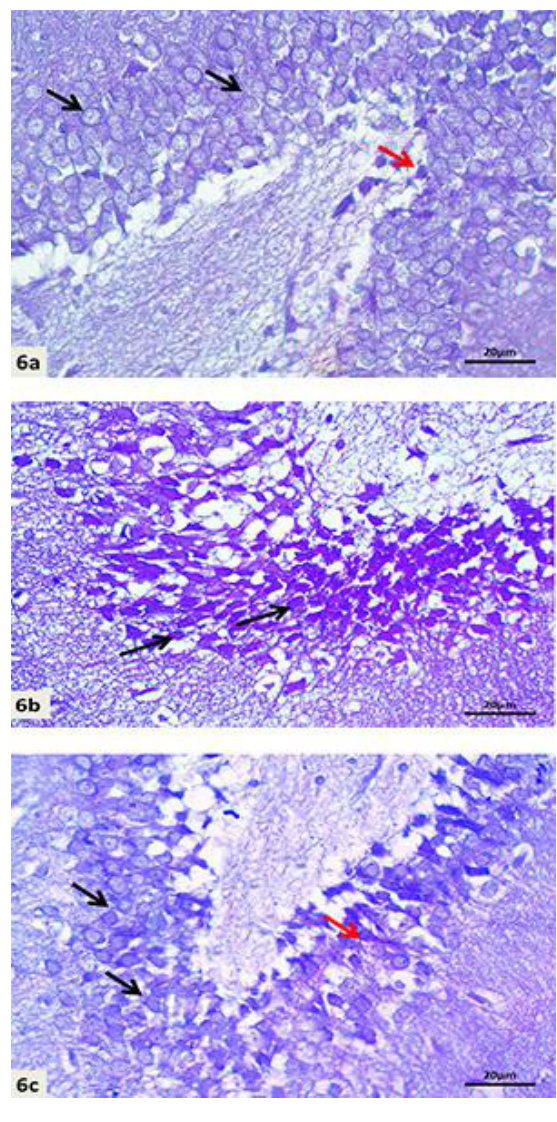
Figures. (6a-c) : Photomicrographs of cresyl violet stained sections of rat hippocampus (dentate gyrus) of (a): control group showing purple Nissl’s granules (arrows) in perikarya of granule cells around their nuclei. Note the ill-defined Nissl’s granules in the spindle immature neurons in the sub-granular zone (red arrow). (b): PTU group showing ill-defined Nissl’s granules (arrows) in perikarya of granule cells (c): PTU+Ash group showing purple Nissl’s granules (arrows) in perikarya of granule cells around their nuclei. Some cells show ill-defined Nissl’s granules (red arrow). (6a-c x 400- scale bar